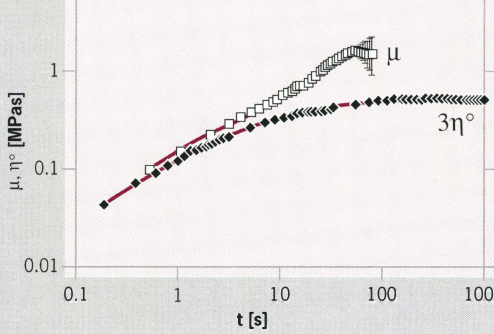
Tabelle 1: Spezifikationen des Dehnungsrheometers mit Metallband-Kiemmen Table 1: Specifications of the elongational rheometer with metal belts